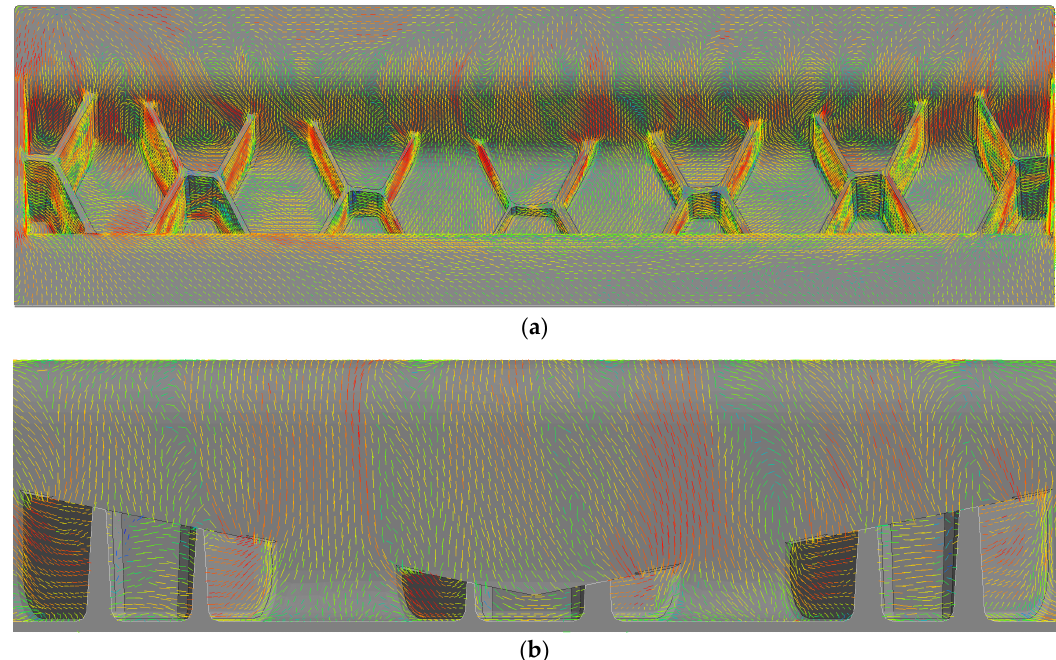
Figure 20. ( a ) Predicted fiber orientation vectors displayed at the part surface of the hat profile; ( b ) detailed view of a cross section (front view) showing the fiber orientation vectors in the three middle ribs.